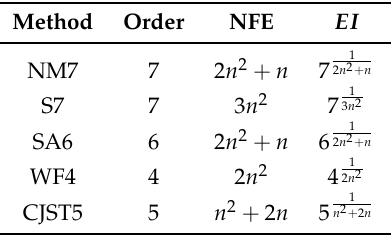
Table 1. Efficiency indices for different methods.